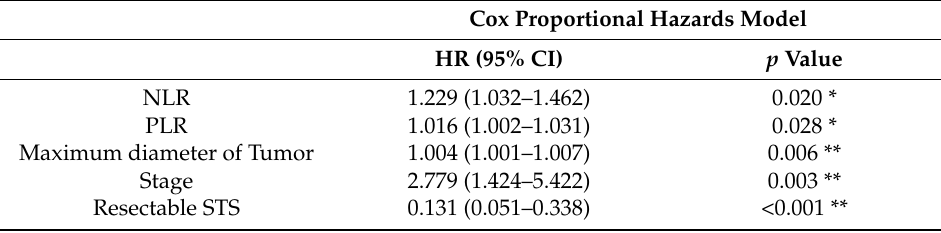
Table 4. Risk factors for poor prognosis of patients with STS.